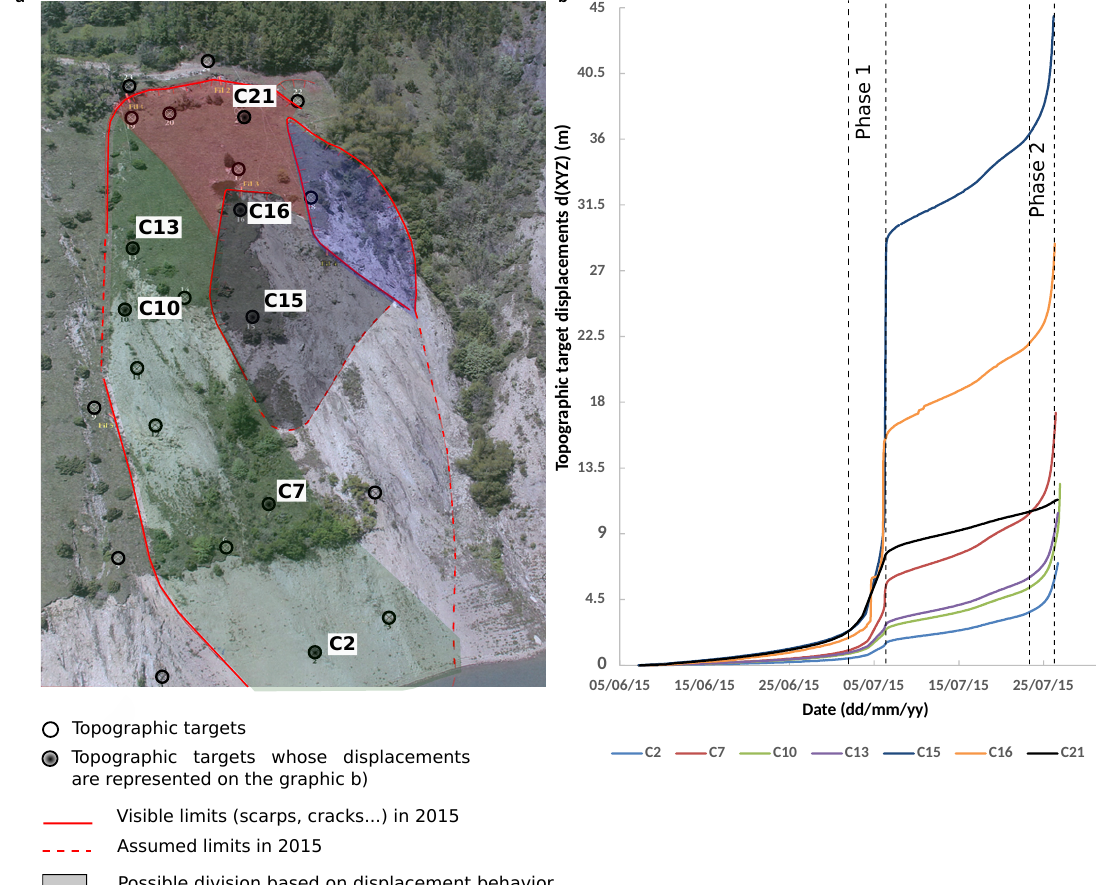
Figure 3. General behavior of the landslide during summer 2015. ( a ) Position of the topographic targets on a photograph [20]. Numerated targets are used in ( b ). ( b ) Displacements in meters of the selected topographic targets (filled circles in ( a )). Phase 1 indicates the main rupture (4–6 July 2015), whereas phase 2 indicates the induced purge of the unstable masses (25–27 July